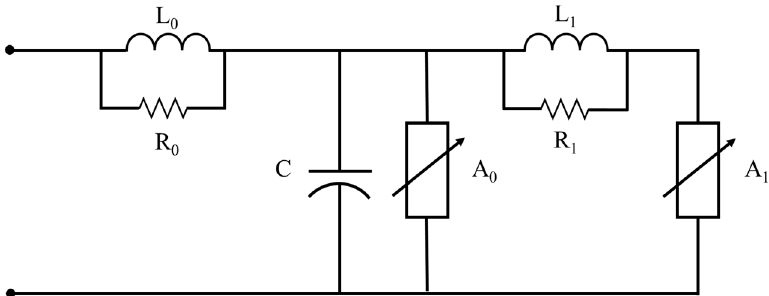
Figure 6. Frequency dependent surge arrester model.